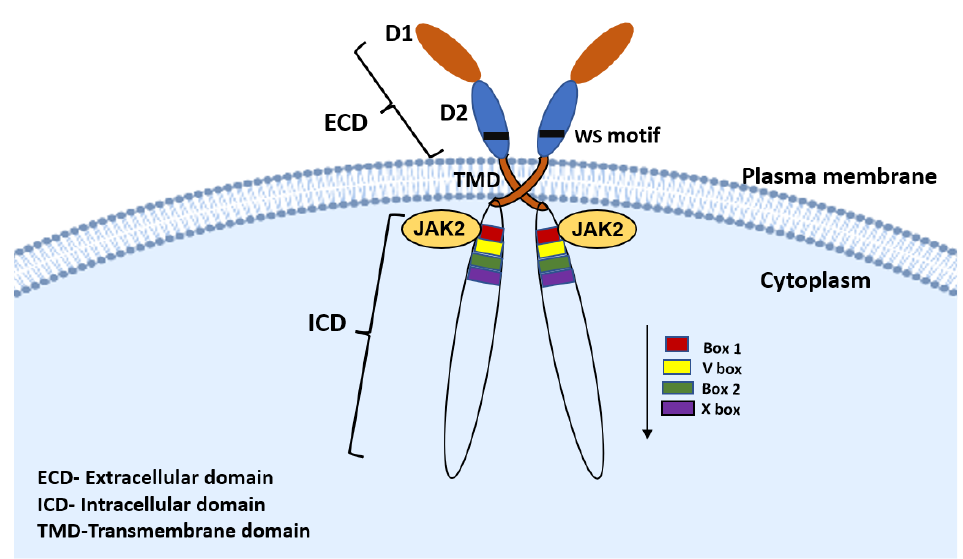
Figure 2. Structure of prolactin receptor. The PRLR consists of three domains, the extracellular domain, which contains a WS motif that acts as a molecular switch for activation, a transmembrane domain, and an intracellular domain showing Box 1 and Box 2 domains. Box 1 interacts with JAK2 and SRC family kinases.